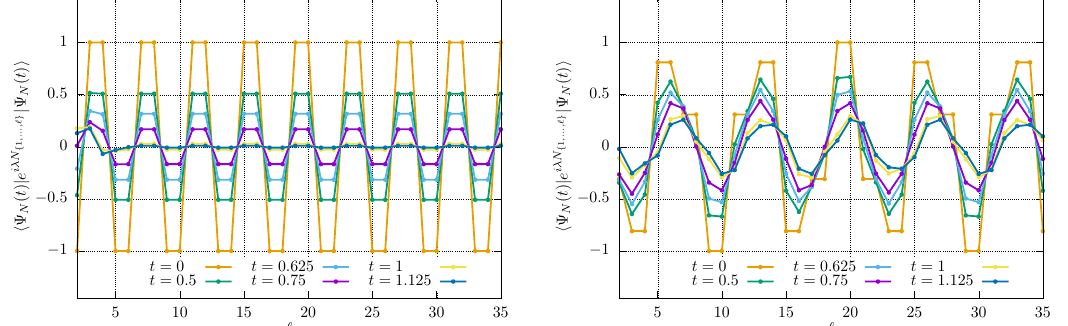
( t , A , λ ) (cf. (67)) vs subsystem size for different Figure 2: Characteristic function χ N times after a quench from the state (60) in the thermodynamic limit. The two panels ( t , A , λ ) approaches correspond to λ = π (left) and λ = 7 π/ 5 (right). In both cases χ N 0 for all (cid:96) for large times, signalling the melting of the